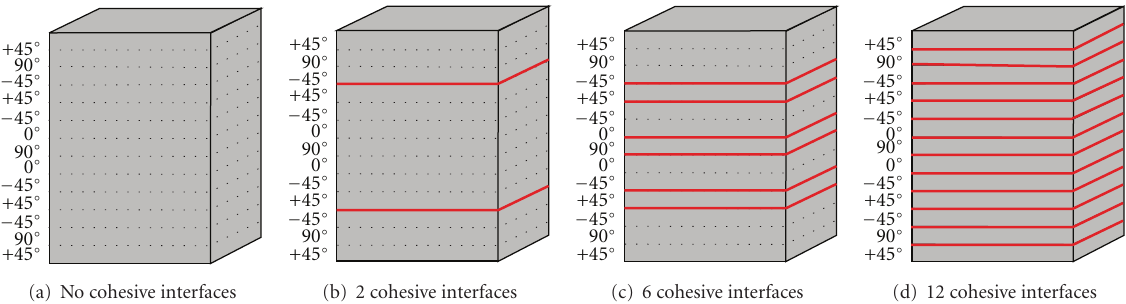
Figure 6: Illustration of investigated delamination modelling